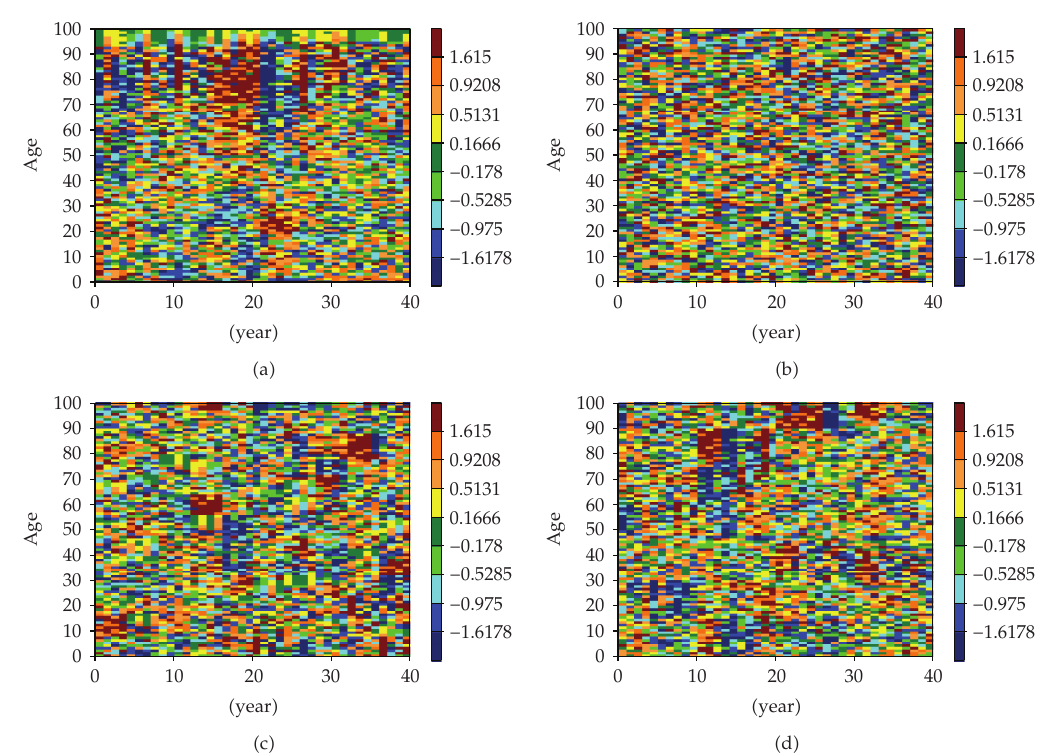
Figure 4: Contour maps for deviance residuals: (cid:2) a (cid:3) raw, (cid:2) b (cid:3) 1 × 1, (cid:2) c (cid:3) 8 × 4, and (cid:2) d (cid:3) 15 × 10.